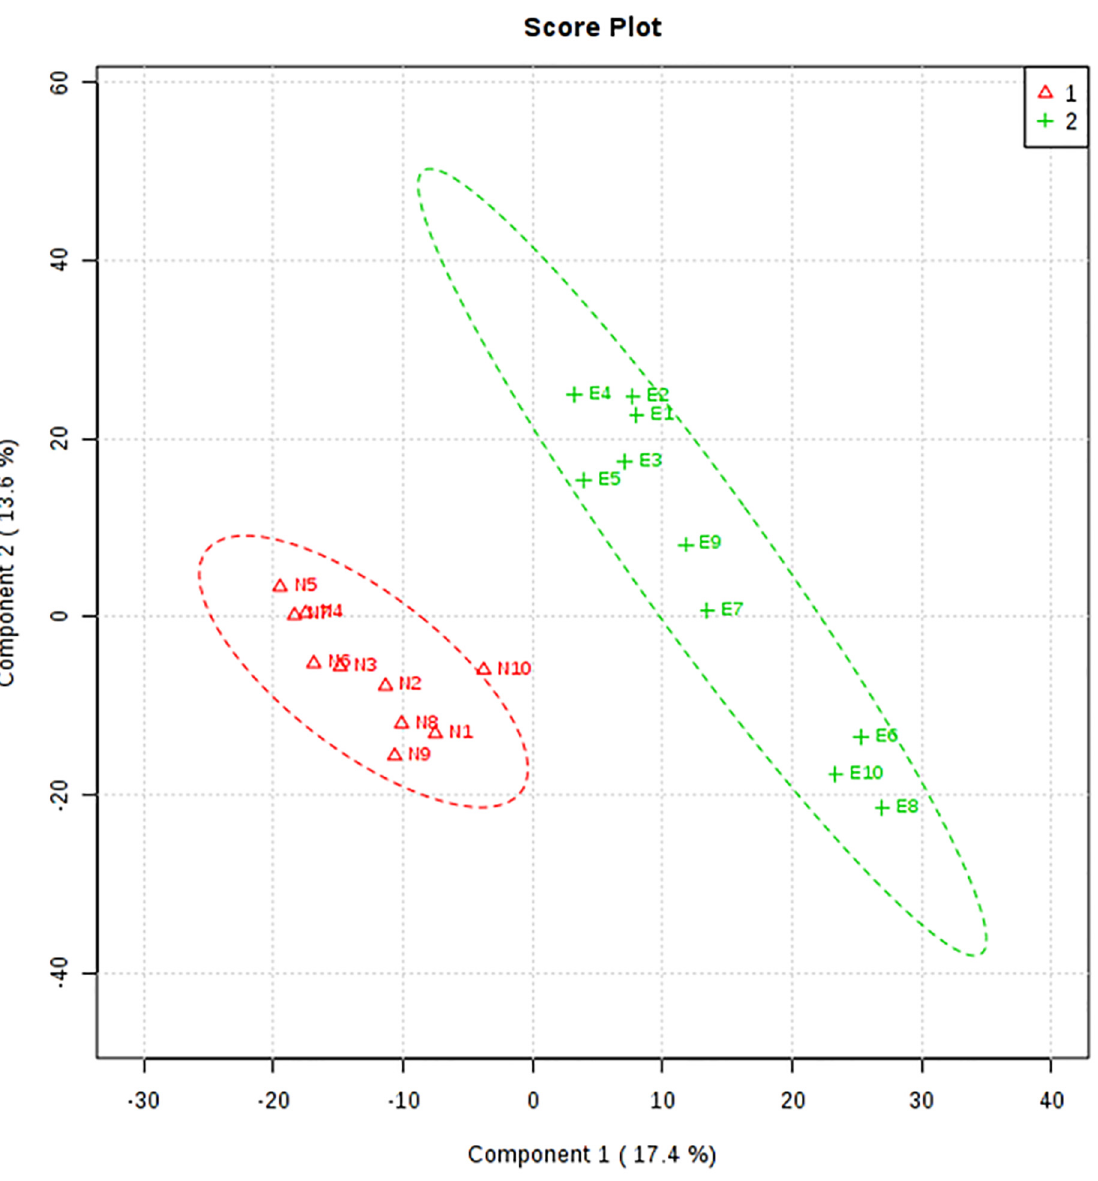
Fig 2. PLS-DA score plot of group separation along the two principal components. The results of the PLS-DA analysis separated the two groups by principal components 1 and 2, which are responsible for 30% of the variation. The q 2 cross-validation was found to be 80%. N = no AUD diagnosis and “ E ” represents ethanol consumption, i.e. positive for an AUD